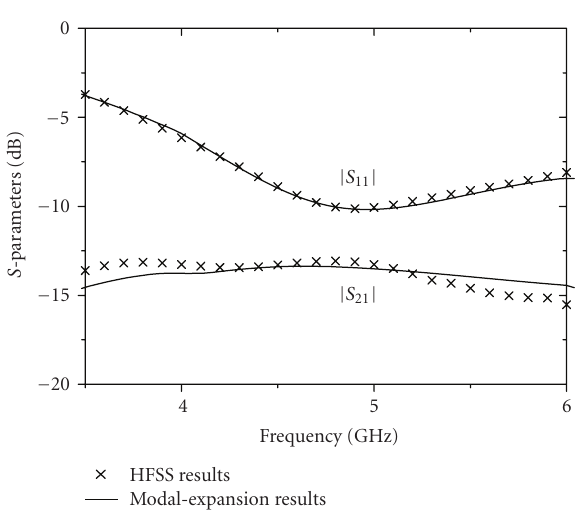
Figure 10: Simulated S -parameter of an array of two thick mono- poles.